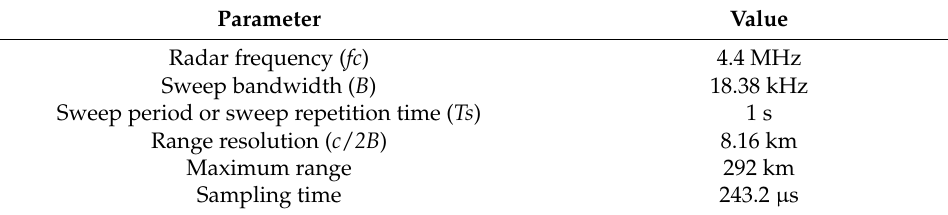
Table 2. Operating parameters of the study area